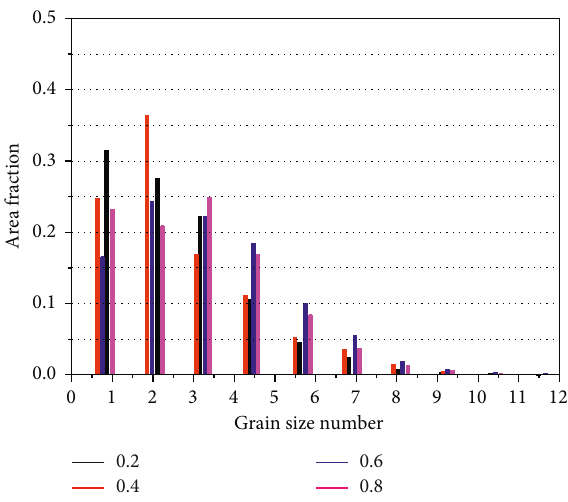
Figure 4: Area fractions of different sizes of grains for specimens deformed at 1150 ° C and 10 − 4 · s − 1 .